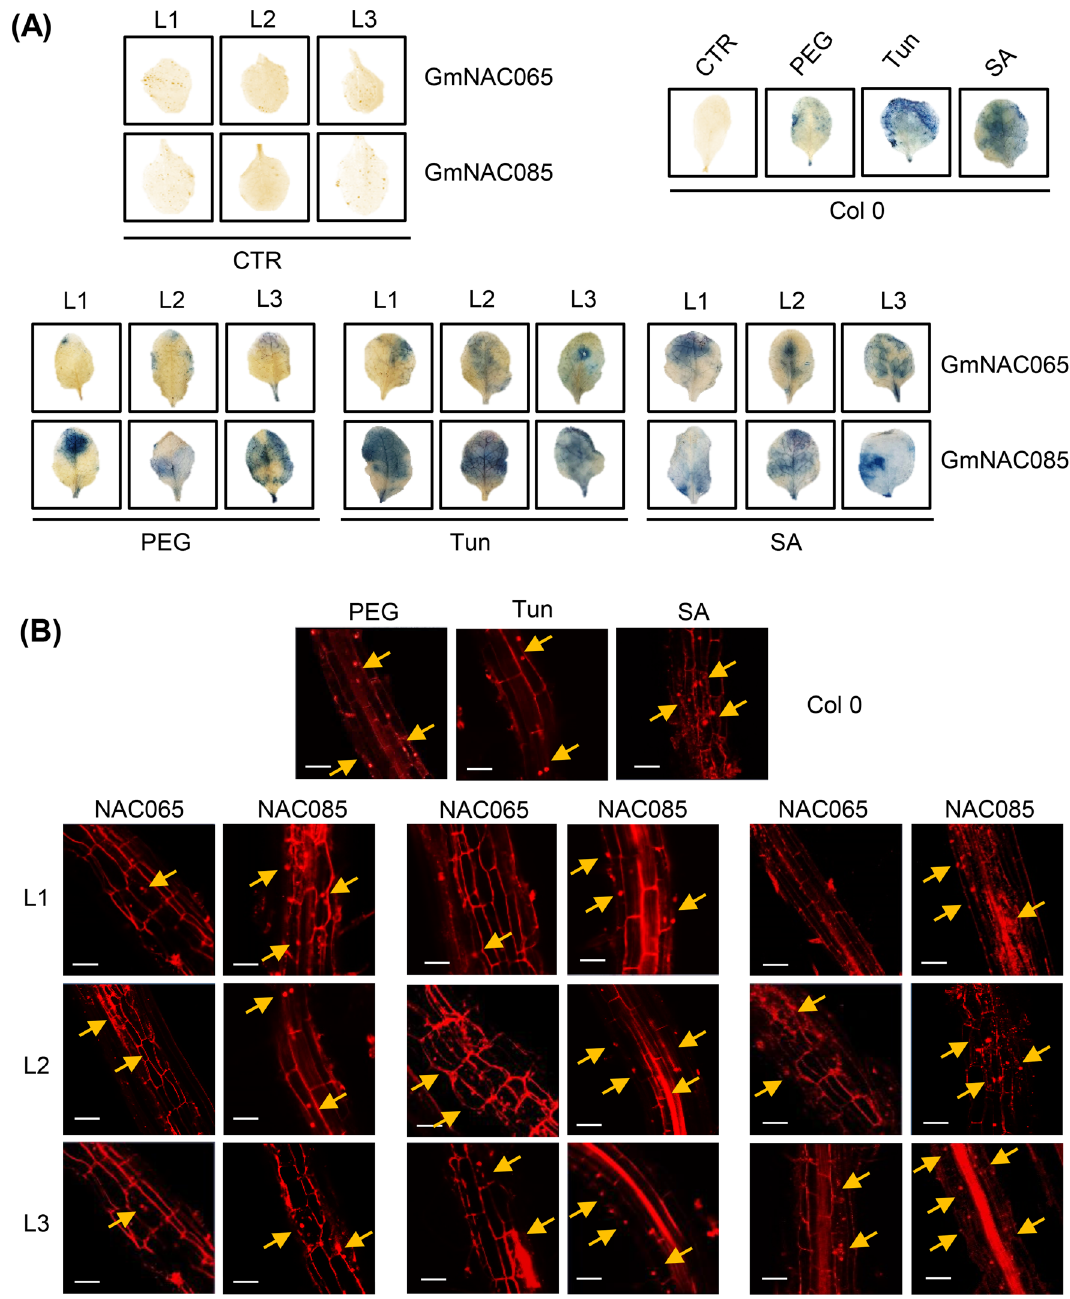
Figure 8. Cell death extent in leaves and roots of GmNAC065-OX and GmNAC085-OX plants. ( A ) Evans blue staining of GmNAC065-OX and GmNAC085-OX leaves under different stresses. 24 h-stressed and non-stressed leaves were exposed to the Evans dye staining solution for 8 h. The intense blue color indicates the extent of cell death. ( B ) Propidium iodide (PI) root-staining in transgenic plants ectopically expressing GmNAC065 and GmNAC085 . Plants were stressed with PEG 8000—10% w/v; Tun—5 µg/mL; and SA—75 µM for 24 h and the roots were subjected to PI-staining solution for 24 h until confocal microscopy scanning. PI stains the cell wall of living cells whereas dead cells show nuclei and cytoplasm stain. Yellow arrows indicate regions with extensive cell death. Scale bars = 20